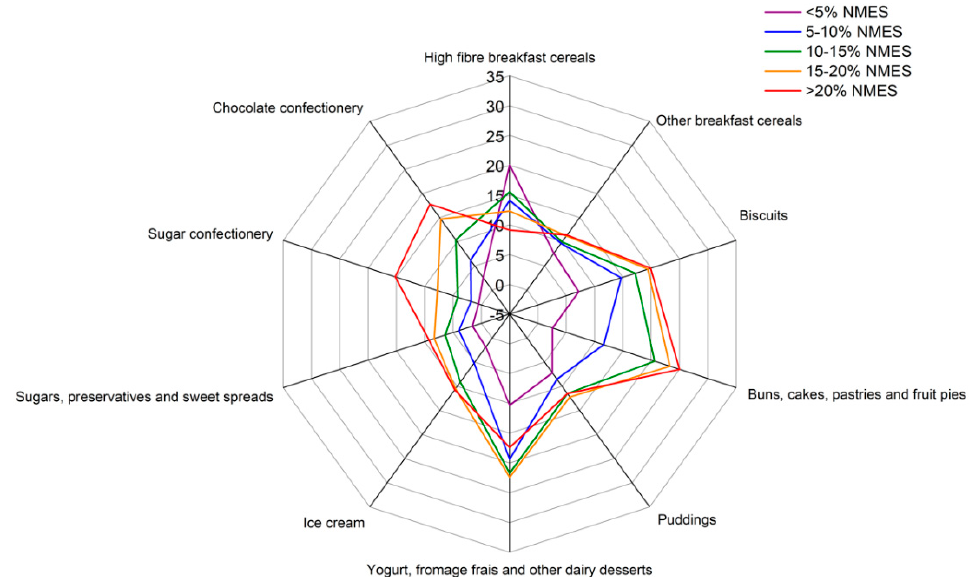
Figure 2. Consumption of sweet foods (g / day) from adolescents aged 11 to 18 years in the National Diet and Nutrition Survey, by category of non-extrinsic milk sugar after the application of survey